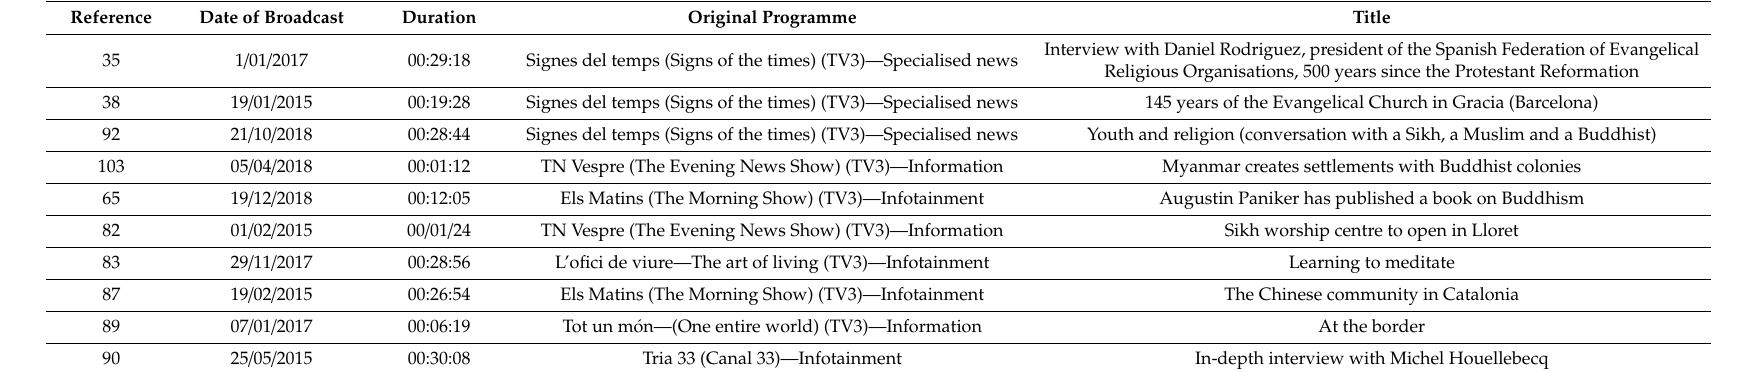
Table 4. Audio-visual material analysed about diverse religious